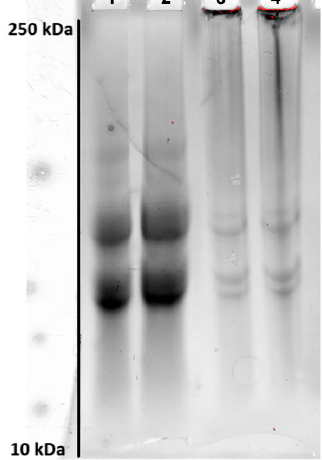
Figure 1. SDS-PAGE analysis of APs mixed with AM (50% ( w/w ) APs and 50% ( w/w ) AM) incubated for 2 h in the absence (1–2: 30 and 60 µ g of the sample, respectively), or the presence of mTGase for 2 h in the absence (1–2: 30 and 60 μ g of the sample, respectively), or the presence of mTGase (40 (40 U/g) (3–4: 30 and 60 µ g of the sample, respectively). U/g) (3–4: 30 and 60 μ g of the sample, respectively).